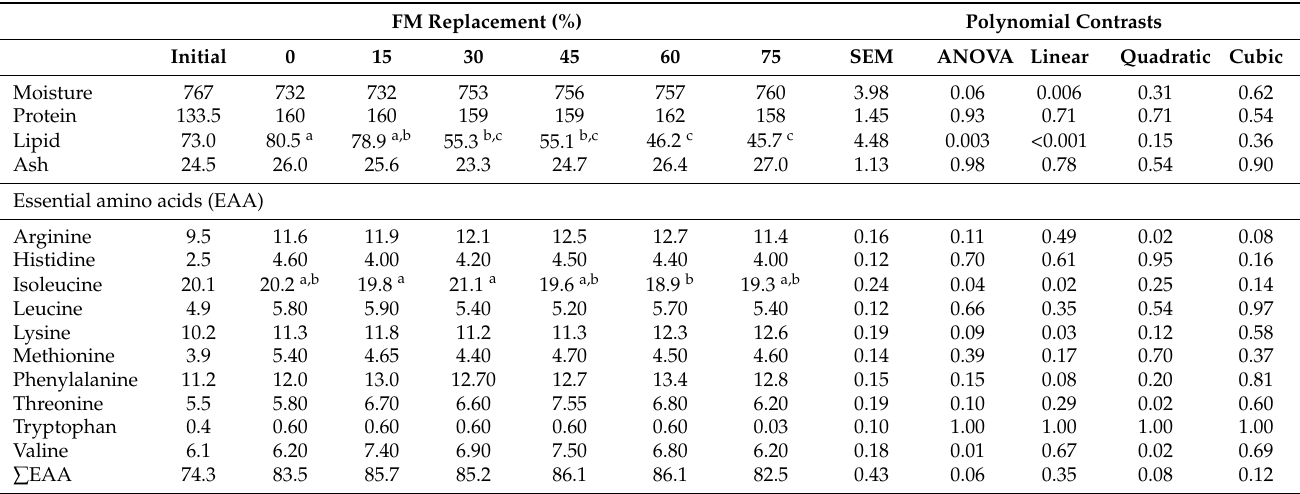
Table 6. Proximate composition and amino acid profiles (g kg − 1 ) of the whole-body of juvenile tench fed practical diets with different levels of replacement of fishmeal (FM) by black soldier fly larvae meal